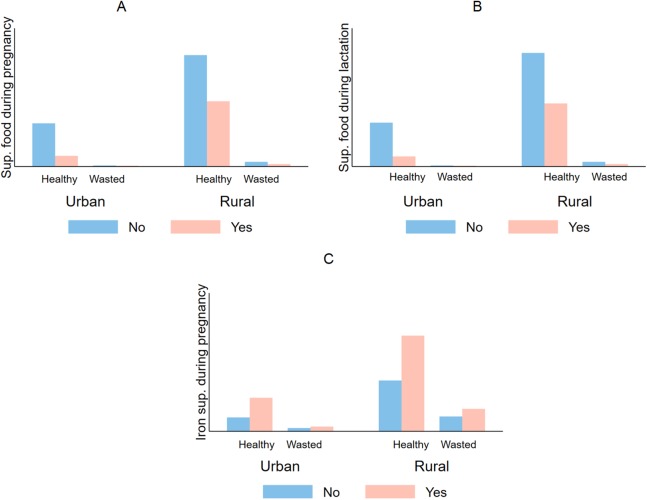
Comparative prevalence of infant wasting by iron supplementation during pregnancy and lactation stratified by type of residency in Timor Leste (2009–2010).In both urban and rural areas mothers who did not take supplementary food during pregnancy (A) and lactation (B), iron supplementation during pregnancy (C), had a higher prevalence of having babies who are wasted (WFH < 2 SD).